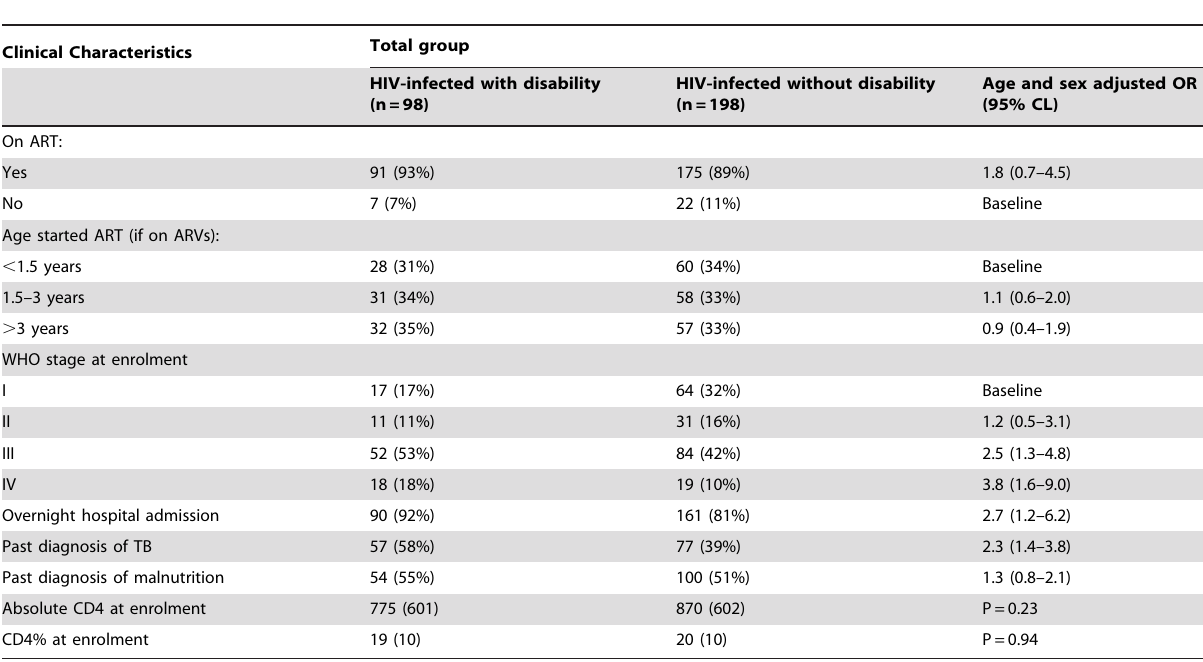
Table 4. Clinical characteristics of HIV-infected children in relation to